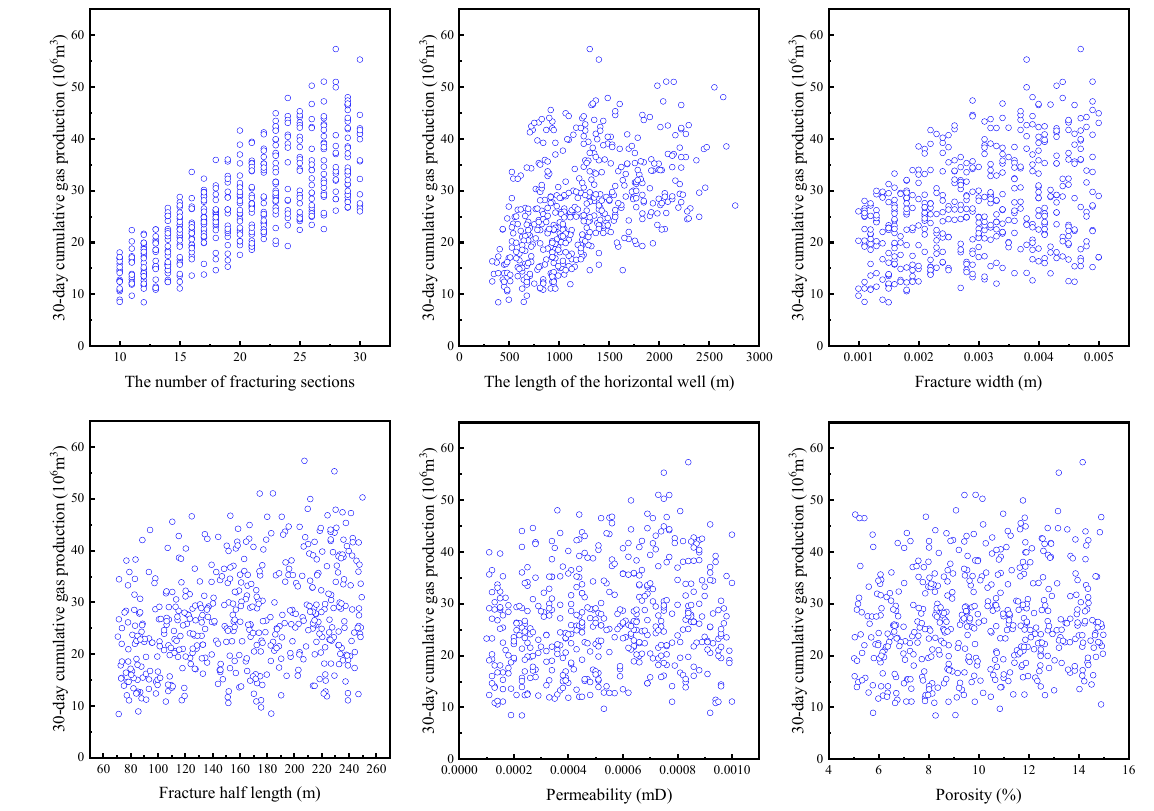
Figure 3. The distribution plots between the input parameters and output parameters.